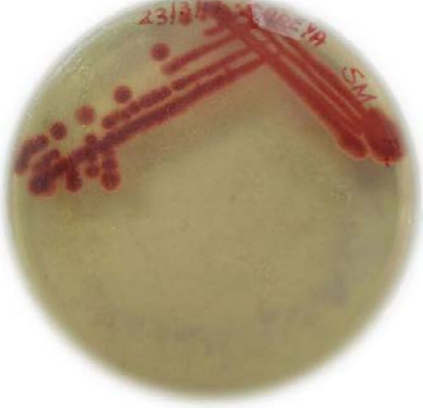
Fig. 1. Pure isolate of S. marcescens